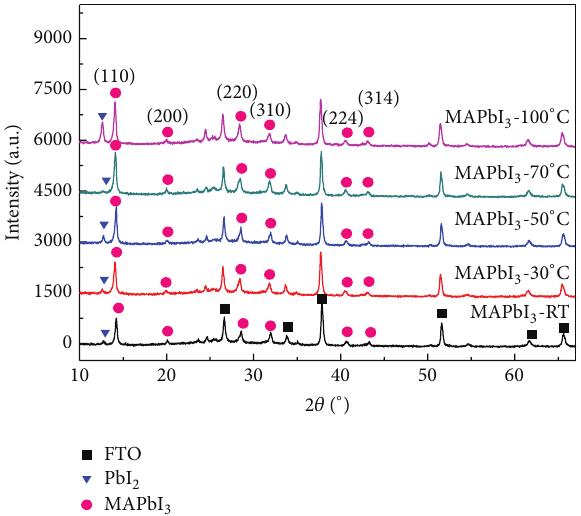
Figure 4: XRD patterns of PbI 2 films deposited on the different preheating substrate temperate of room temperature, 30 ∘ C, 50 ∘ C, 70 ∘ C, and 100 ∘ C, respectively.